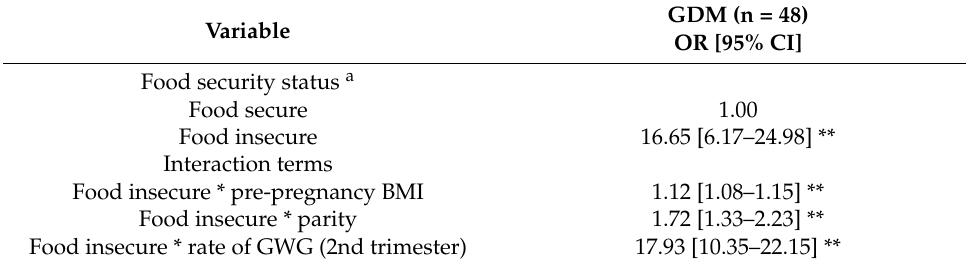
Table 3. Unadjusted and adjusted odds ratio (OR) and 95% confidence intervals (95% CI) for associations between food security status and gestational diabetes mellitus (GDM) (n = 452). Variable